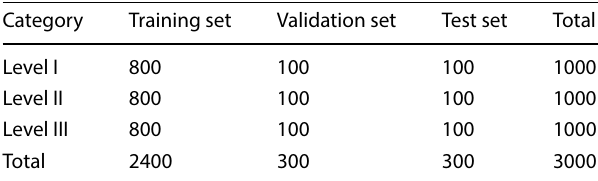
Table 3 The spectrum data